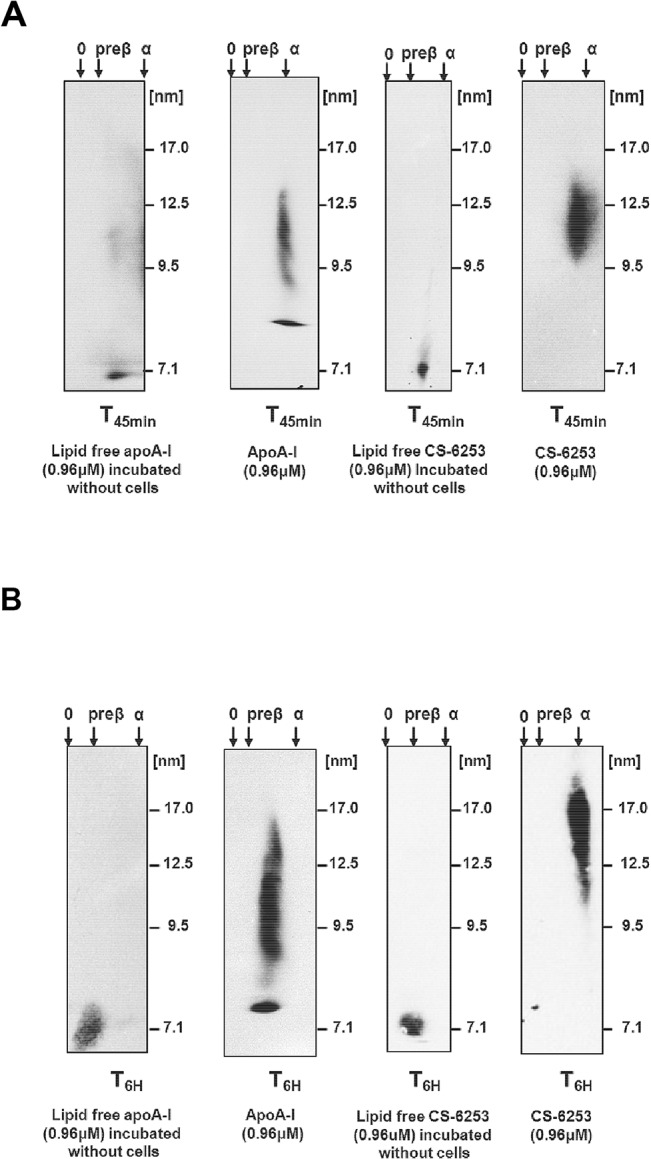
Time course ability of CS-6253 to generate nHDL-mimetic like particles.(A and B): nHDL-CS-6253 and nHDL-apo A-I released to the medium at specific time points (45 min and 6 h) from BHK cells expressing ABCA1 were analyzed by 2D-PAGGE. Apo A-I was detected by polyclonal anti-apo A-I, CS-6253 peptides was detected by anti-CS-6253 and revealed by chemiluminescence. Molecular markers are indicated.